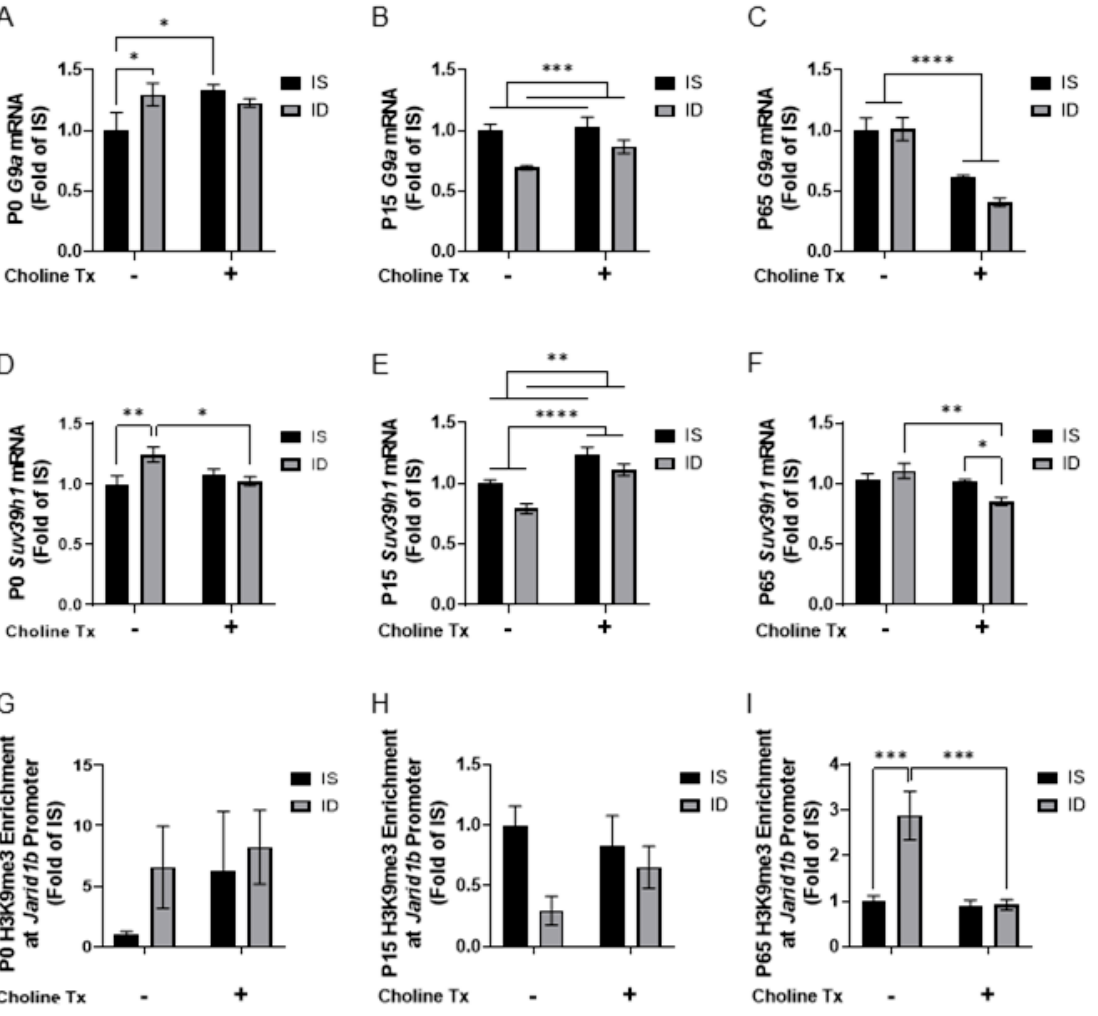
Figure 4. Iron deficiency and choline supplementation alter hippocampal histone H3K9 methylation. ( A – C ) Expression levels of G9a in the 4 groups at P0 ( A ), P15 ( B ) and P65 ( C ). ( D – F ) Expression levels of Suv39h1 in the 4 groups at P0 ( D ), P15 ( E ) and P65 ( F ). ( G – I ) H3K9me3 enrichment at the Jarid1b promoter in the 4 groups at P0 ( G ), P15 ( H ) and P65 ( I ). All data were assessed with RT-qPCR or qChIP and normalized to the age-matched IS group. Tx: Treatment (Supplementation). Values are mean ± SEM; n = 5–6/group; * p < 0.05, ** p < 0.01, *** p < 0.001, **** p < 0.0001.